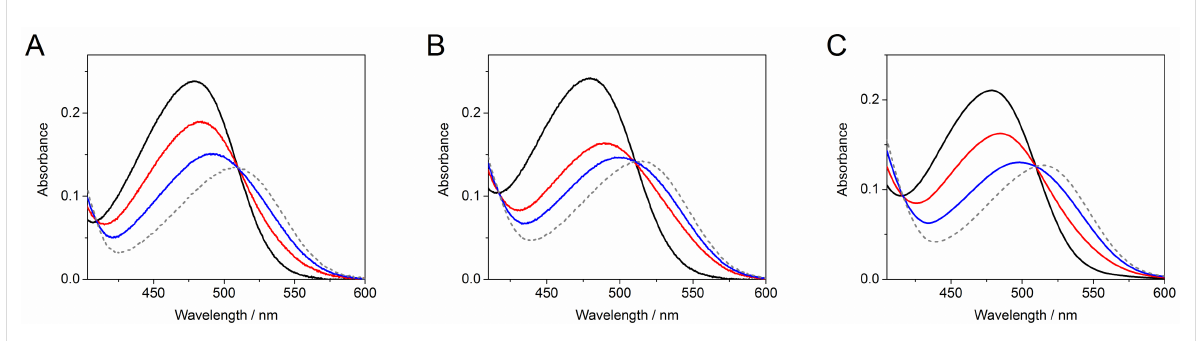
Figure 2: Absorption spectra of the Z -isomer (black), two photostationary states obtained upon irradiation with 520 nm (red) and 470 nm (blue) light for (A) 1b , (B) 1c , (C) 2 in water, c = 20 μ M, 20 °C. Grey dashed line represents the spectra of the corresponding E -isomers calculated by the Fischer